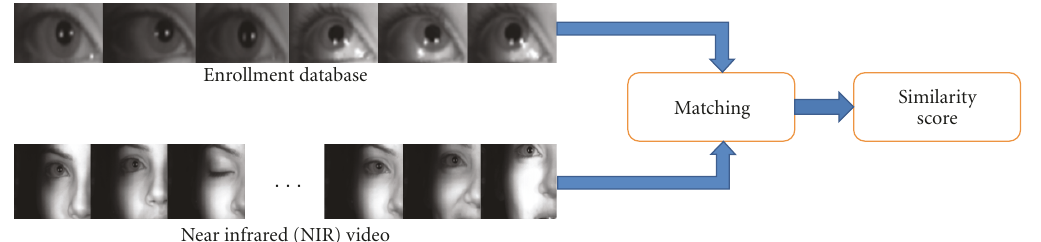
Figure 14: Matching protocol for noncooperative iris recognition.